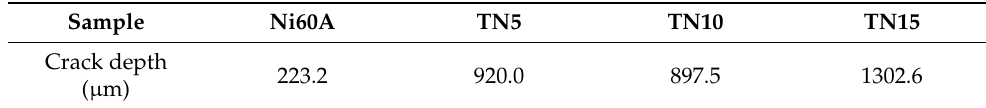
Figure 9. The microscopic morphology of different samples after 1200 cycles: ( a ) Ni60A; ( b ) TN5; ( c ) TN10; ( d ) TN15. Table 4. Propagation depth of the main crack after 1200 cycles.